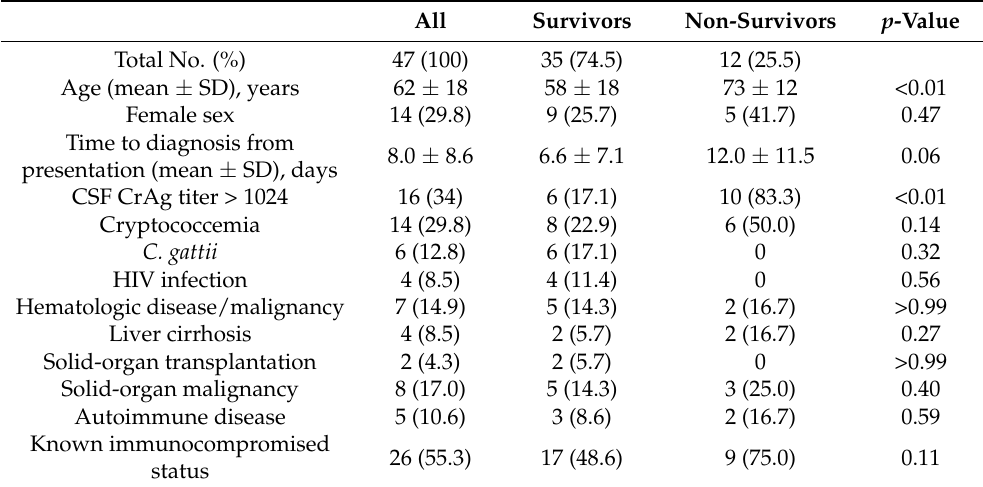
Table 3. Demographic and clinical characteristics of 47 patients with cryptococcal meningoencephalitis. All